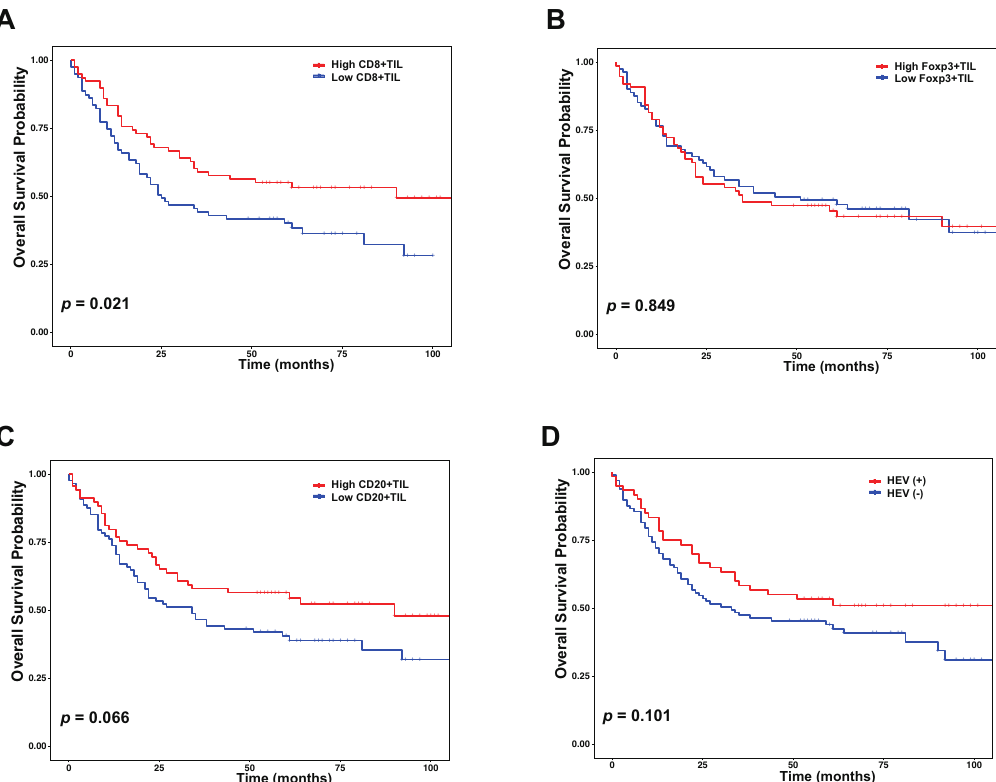
Figure 3. Prognostic analysis for CD8 + TILs, Foxp3 + TILs, CD20 + TILs, and HEVs in gastric cancer. ( A ) The Kaplan–Meier curve demonstrates a longer overall survival (OS) in patients with a high CD8 + TIL density. The significant di ff erences of OS in patients were not observed according to the level of ( B ) Foxp3 + TILs, ( C ) CD20 + TILs, and ( D ) the presence or absence of HEVs. 3.3. Combined Analysis with CD8 + TIL and